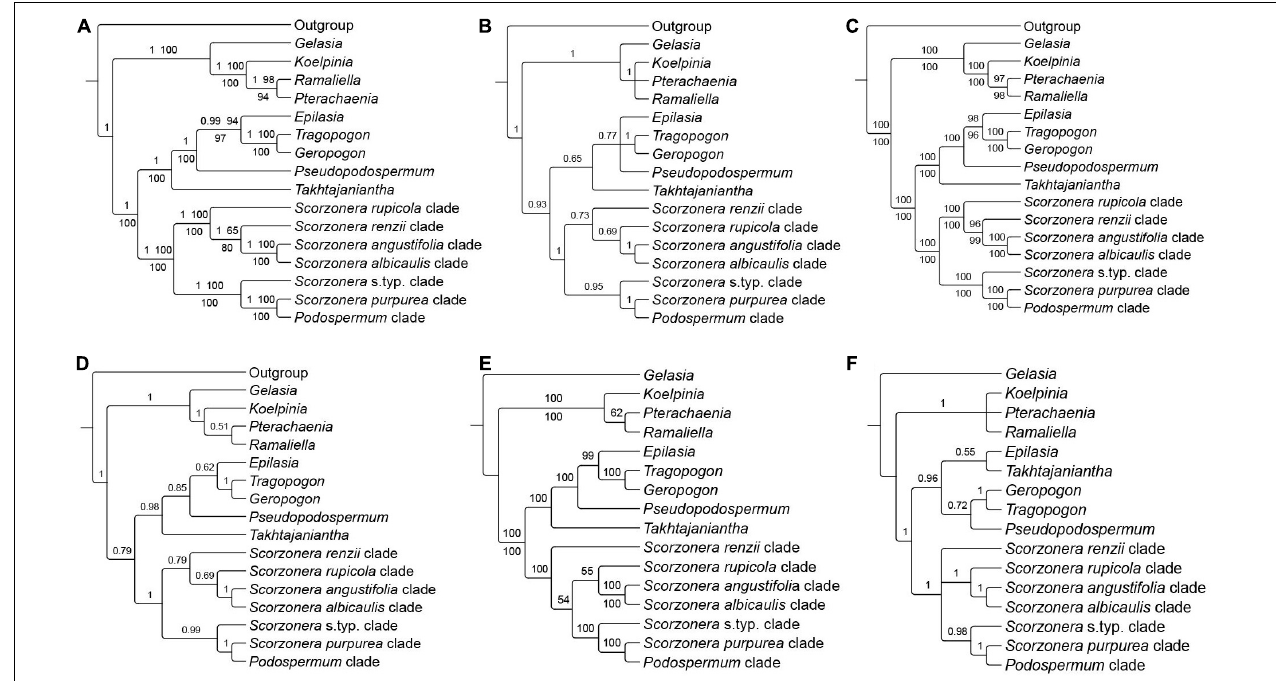
FIGURE 3 | Backbone topology of phylogenetic relationships among major lineages of subtribe Scorzonerinae, inferred from different nuclear [original loci set (OLS), enlarged loci set (ELS), supercontig] datasets under the concatenation [Maximum Likelihood (ML) analysis performed on no-partitioned and partitioned concatenated datasets and Bayesian inference] and coalescent approaches. (A) OLS concatenated species tree, posterior probabilities (PP) from Bayesian analysis and bootstrap values from ML no-partitioned analysis (BS-NP) above the branches and bootstrap values of ML partitioned analysis (BS-P) below the branches; (B) OLS coalescent species tree; (C) ELS concatenated species tree, BS-NP support values of ML no-partitioned analysis above the branches and BS-P of ML partitioned analysis below the branches; (D) ELS coalescent species tree; (E) Supercontig concatenated species tree, BS-NP support values of ML no-partitioned analysis above